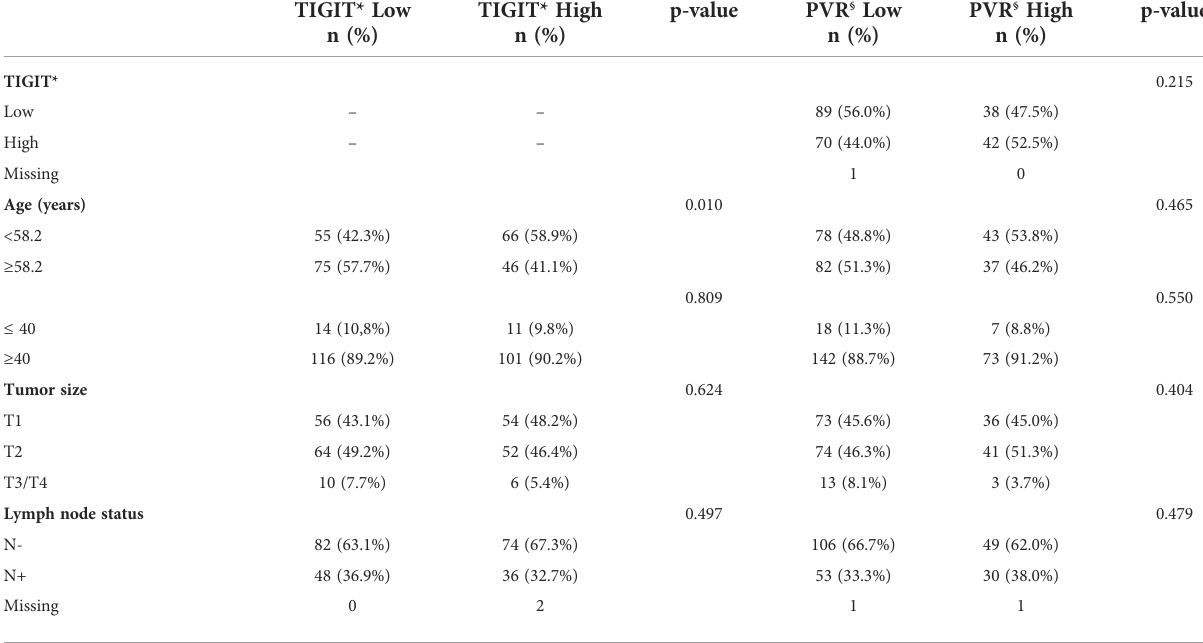
TABLE 2 Correlations between TNBC clinicopathological features and TIGIT and PVR